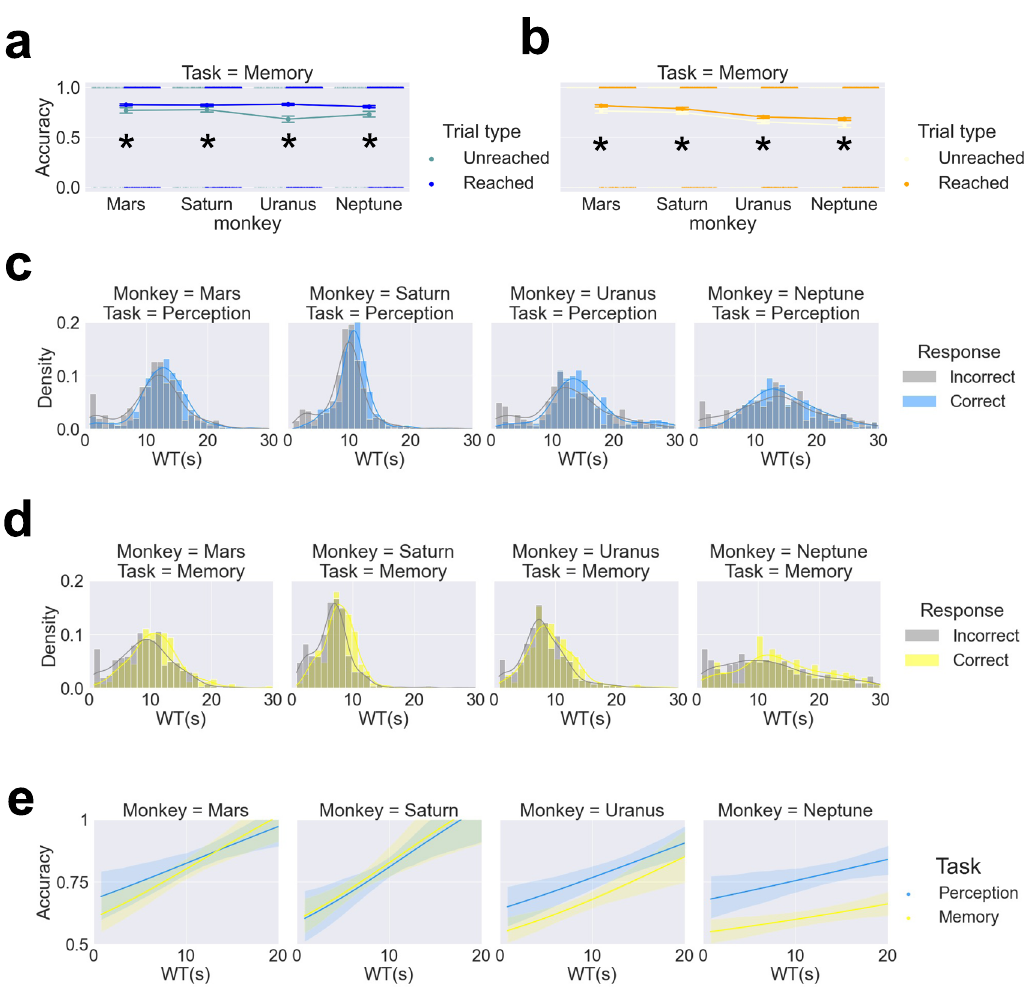
Fig. 5 Wagered time re fl ects monkeys ’ task performance (correctness) in both memory and perception tasks. Difference in accuracy between unreached trials and reached trials in the perception ( a ) and memory tasks ( b ). Differences between the WTs of correct and incorrect trials for each monkey in the perception ( c ) and memory tasks ( d ). WT tracks response outcome (correct/incorrect) in both memory and perception tasks. The lines are logistic regression fi ts for accuracy with WT as a factor. The WT bin size was set to 1 s; coloured lines indicate kernel density estimation ( e ). Error bars indicate ± one standard error; * indicates p < 0.05. Shaded areas indicate bootstrap-estimated 95% con fi dence intervals for the regression